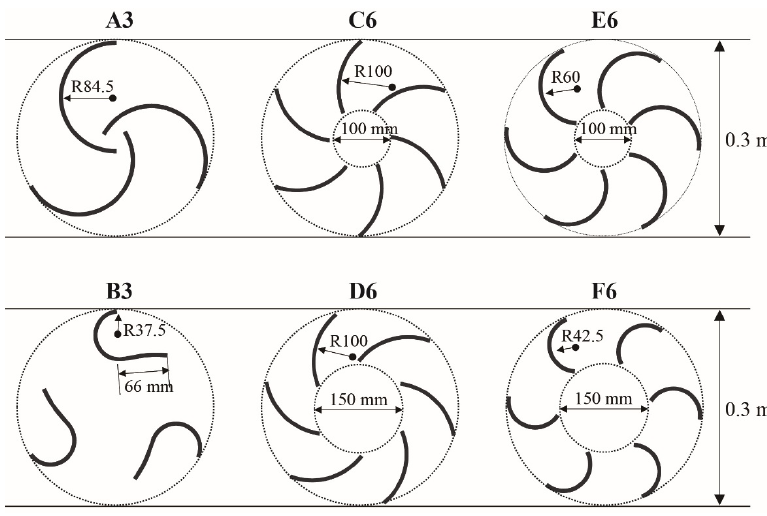
Figure 9. Cross sectional diagrams of the rotors considered in this study.